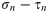
Nonlinear failure criterion in the Mohr plane σn−τn.